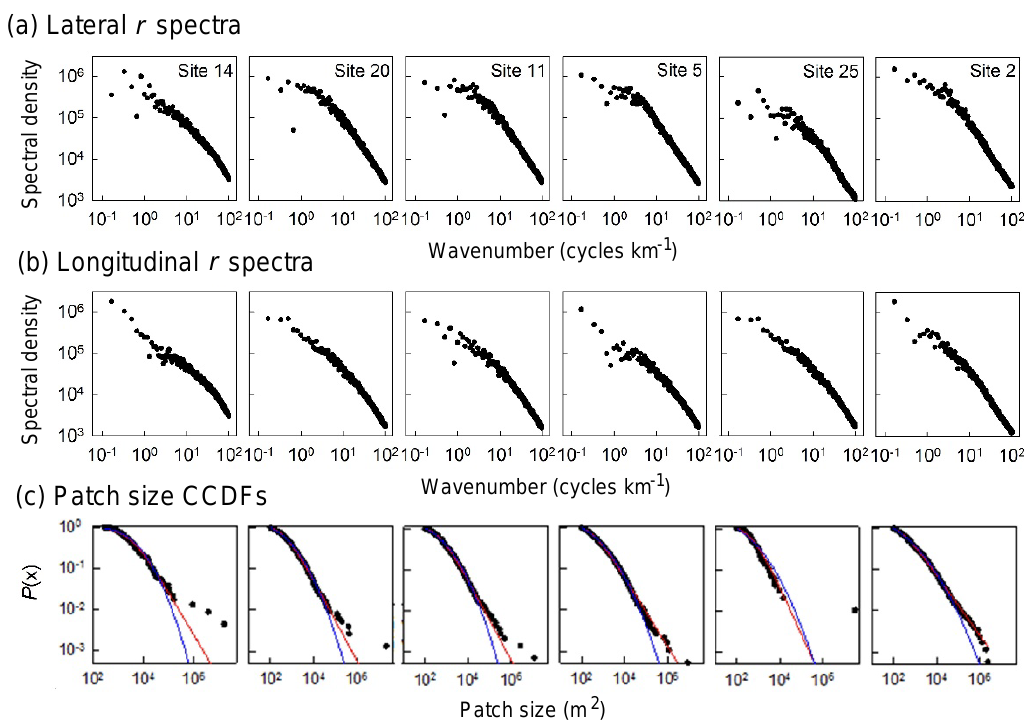
Figure 3. (a) Lateral r spectra (limited to ± 10 ◦ perpendicular to the pattern) monotonically decreased with no evidence of peaks, indicating aperiodic behavior in the direction of presumed regularity. (b) Longitudinal r spectra (limited to ± 10 ◦ in the direction parallel to the pattern) show similar monotonic behavior. The form for both lateral and longitudinal directions is similar, with both exhibiting a mixture of power-law and exponential behavior. The location of the exponential-like curvature appears to be influenced by both orientation and pattern condition, suggesting a weak-acting scale-dependent mechanism. (c) Patch size distributions across sites are well described by the generalized Pareto distribution (red lines). Sites with high ridge densities (e.g., sites 2, 5 and 25) have maximum patch sizes much greater than expected from the GP distribution. Conversely, sites in excessively inundated sections (e.g., site 20) show slightly steeper tails, consistent with a lognormal distribution (blue lines), though not enough to rule out the